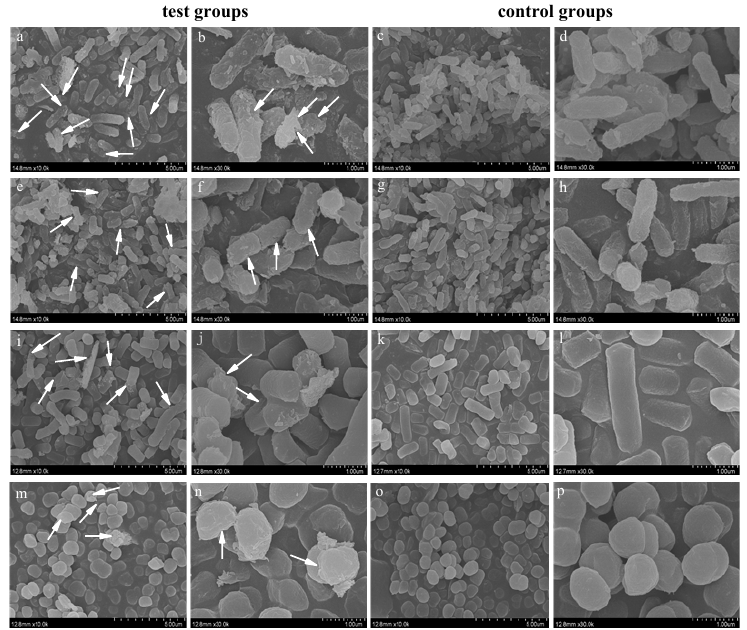
Figure 11. Morphological changes of different bacteria before and after PtNPs treatment: ( a – d ) E. coli ; ( e – h ) S. typhimurium ; ( i – l ) B. subtilis ; ( m – p ) S. aureus .